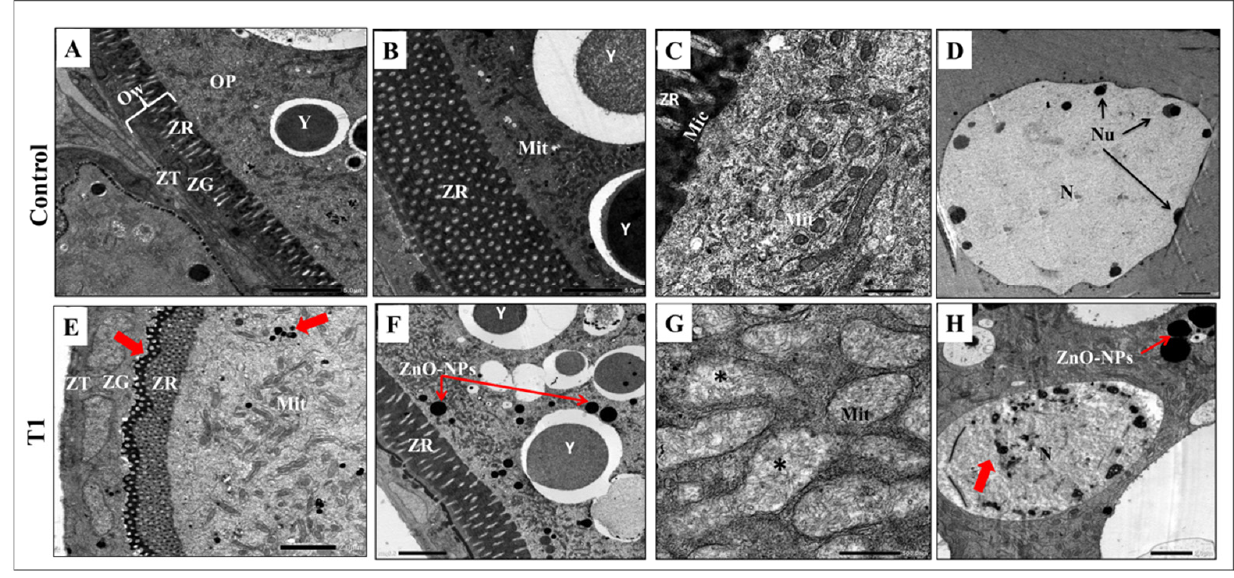
Figure 5. Transmission Electron Microscopy observation of the control and T1 ovaries: ( A – D ) Trans- Figure mission electron micrographs of the control vitellogenic oocyte showing the intact oocyte membrane with distinct cell layers of theca cells (ZT), granulosa cells (ZG), and zona radiata (ZR), large yolk granules, plenty of normal mitochondria, and a normal nucleus. ( E – H ) Transmission electron mi- crographs of the T1 ovary showing diffusion of ZnO-NPs to the ooplasm through the cell membrane (red arrows); notice the mild alteration of the cell membrane, mitochondrial degeneration, and chro- matin condensation. OW: oocyte wall, ZT: Zona theca, ZG: Zona granulosa, ZR: Zona radiata, OP: ooplasm, Y: yolk, Mit: Mitochondria, Mic: microvilli, N: nucleus, Nu: nucleolus. T1 = group was exposed to 1/5th of the estimated LC50 of ZnO-NPs in water daily for two weeks (15 days). * p < 0.05.